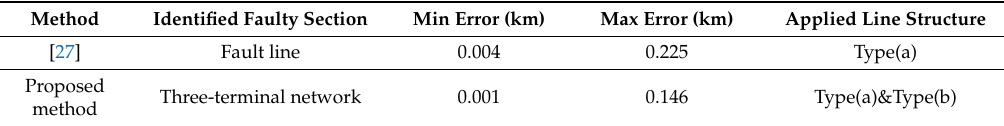
Table 10. Comparison with the existing methods in